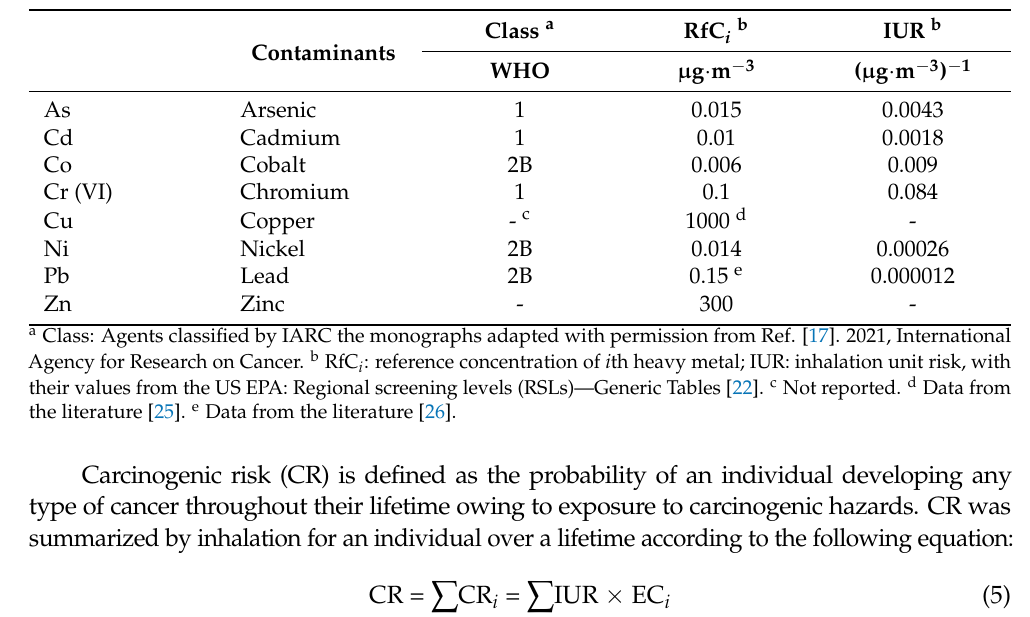
Table 1. Toxicological parameters of the heavy metals used for health risk assessment via the inhalation